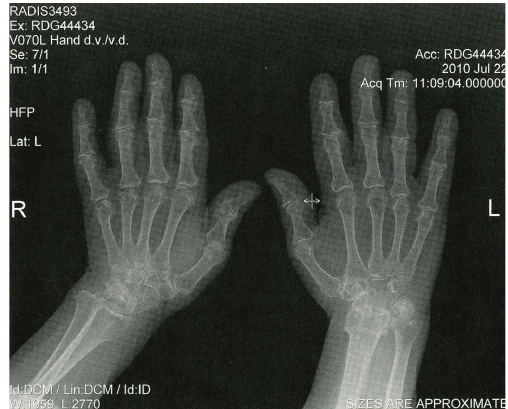
Figure 2: Radiological changes in acromegalic arthropathy on X- ray scan (with permission of Peter Vaˇnuga, MD, PhD., National institute of endocrinology and diabetology, L’ubochˇna, Slovakia).